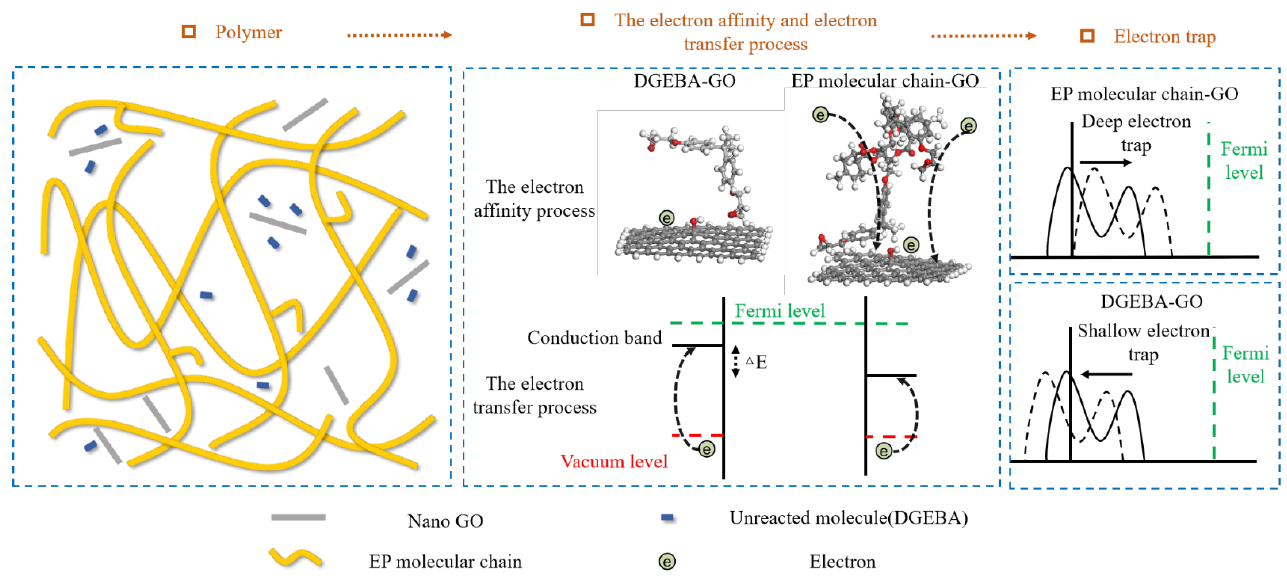
Figure 7. Analysis of electron traps in EP/GO nanocomposites.